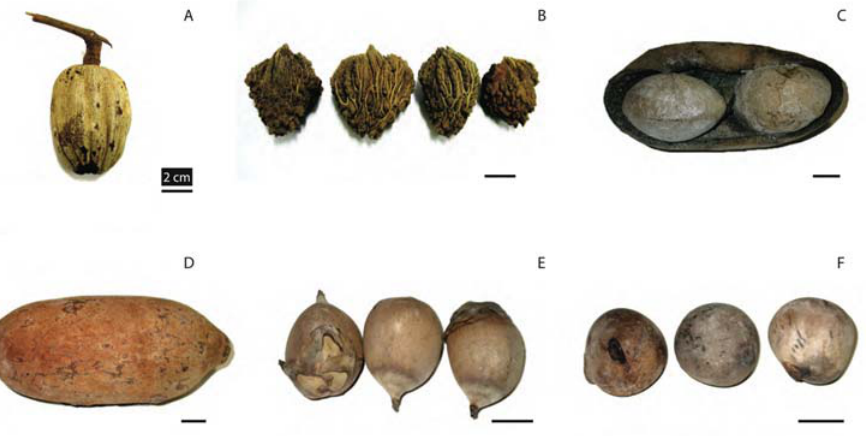
Figure 1. Examples of megafauna fruits and seeds. a, Lacunaria jemmani , Quiinaceae. b, Parinari montana , Chrysobalanaceae (seeds); c, Caryocar villosum , Caryocaraceae, fruit split open with two seeds; d, Theobroma grandiflora , Malvaceae; e, Attalea martiana , Arecaceae; f, Phytelephas macrocarpa , Arecaceae (seeds). Black line is 2 cm length. Photos from specimens at Herbarium Joa˜o Murc¸a Pires (MG) of the Museu Paraense Emı´lio Goeldi, Bele´m, Brazil; by PJ.